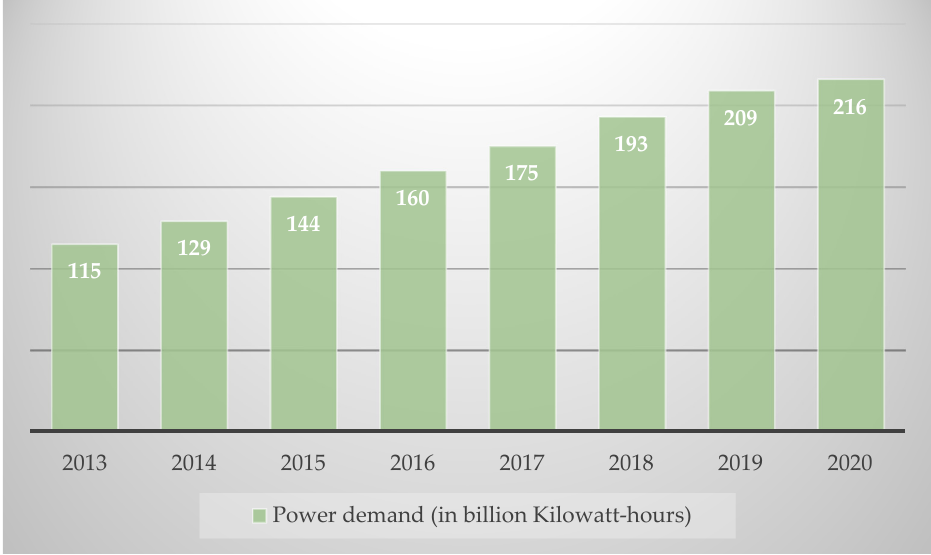
Figure 3. Vietnamese power demand from 2013 to 2020 (Source: Statistics (2020)) [37].